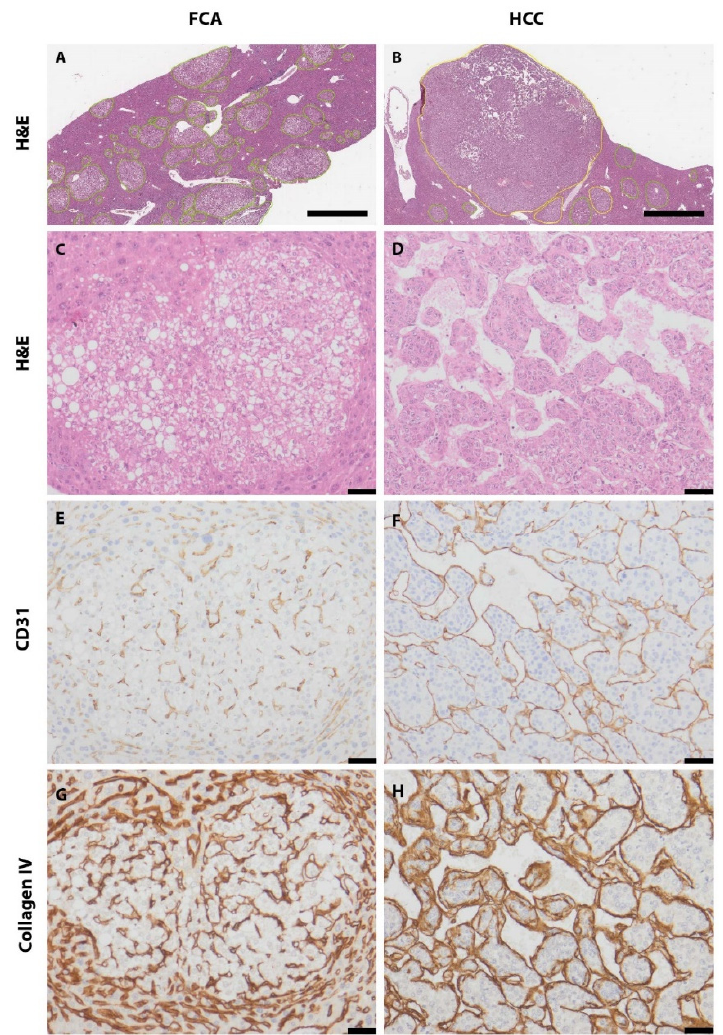
Figure 1. Annotation and immunostaining of foci of cellular alteration (FCA) and hepatocellular carcinoma (HCC). FCA annotated with green color in H&E ( A ); HCC annotated with yellow color in H&E ( B ); representative image of FCA ( C ) (H&E) and HCC ( D ) (H&E); CD31 immunostaining in FCA I and HCC ( E , F ). Collagen IV immunostaining in FCA ( G ) and HCC ( H ). Scale bar ( A , B ): 2 mm (magnification 1.5 × ). Scale bar ( C – F ): 50 µ m (magnification 20 × ).